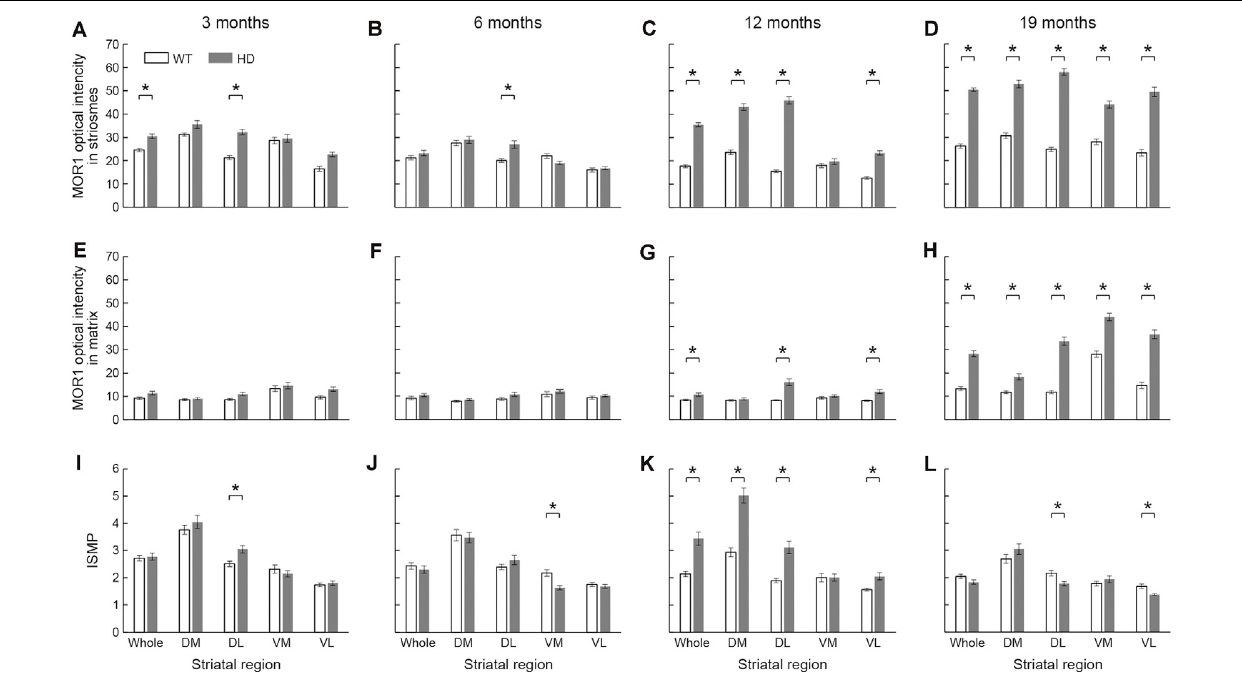
FIGURE 5 | The densitometric analysis across four different ages in the rostral caudoputamen of WT and Q175KI mice. The intensity of the MOR1-immunopositive (striosomal) zones increased in the whole ( p < 0.001) and dorsolateral ( p < 0.001) caudoputamen at 3 months of age (A) , in the dorsolateral caudoputamen ( p = 0.001) at 6 months of age (B) , in all areas ( p < 0.001) except the ventromedial caudoputamen at 12 months of age (C) , and in all areas ( p < 0.001) at 19 months of age (D) in Q175KI mice, relative to WT mice. The intensity of the MOR1-immunonegative (matrix) zones was not different between WT and Q175KI mice at 3 and 6 months of age (E,F) . The intensity of the MOR1-immunonegative zones increased in the whole ( p = 0.002), dorsolateral ( p < 0.001) and ventrolateral ( p < 0.001) caudoputamen at 12 months of age (G) , and in all segments at 19 months of age ( p < 0.001; H ) in Q175KI mice, relative to WT mice. The index of striosome-to-matrix predominance (ISMP) increased in the dorsolateral caudoputamen ( p = 0.004) at 3 months of age (I) , but it decreased in the ventromedial caudoputamen ( p < 0.001) at 6 months of age (J) in Q175KI mice relative to WT mice. The ISMP strikingly increased in the whole ( p < 0.001), dorsomedial ( p < 0.001), dorsolateral ( p < 0.001), and ventrolateral ( p = 0.002) caudoputamen at 12 months of age (K) . The ISMP was normalized in the whole, dorsomedial and ventromedial caudoputamen ( p > 0.005), but it was still higher in the dorsolateral ( p = 0.004) and ventrolateral ( p = 0.001) caudoputamen at 19 months of age (L) in Q175KI mice than in WT mice. Asterisks indicate significant differences ( p < 0.005 after Bonferroni